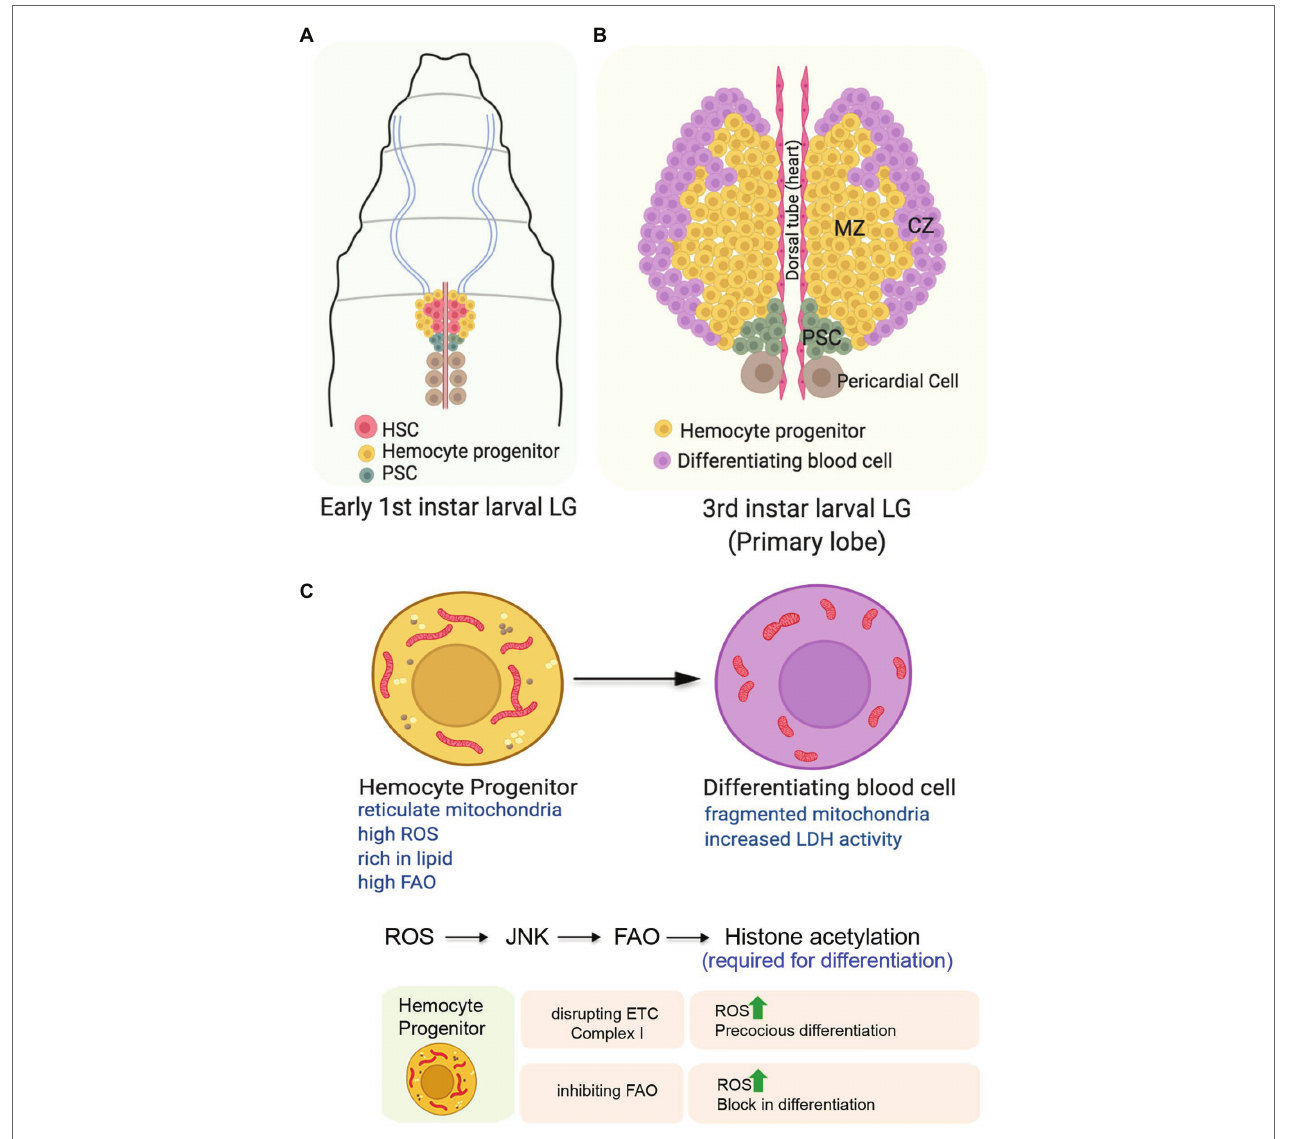
FIGURE 5 | Role of mitochondria in determining the state and fate of hemocyte progenitors in the larval lymph gland of Drosophila . (A) Organization of the early first instar larval lymph gland showing the Hematopoietic Stem Cells (HSCs), the hemocyte progenitors, and the niche cells. (B) Schematic representation of the third instar larval lymph gland depicting the position of the different zones. The expanded forms of the acronyms used are provided in the text. (C) Changes in mitochondrial form and function and its importance for the differentiation of the hemocyte progenitors. Table showing the outcome of altering mitochondrial function in the hemocyte